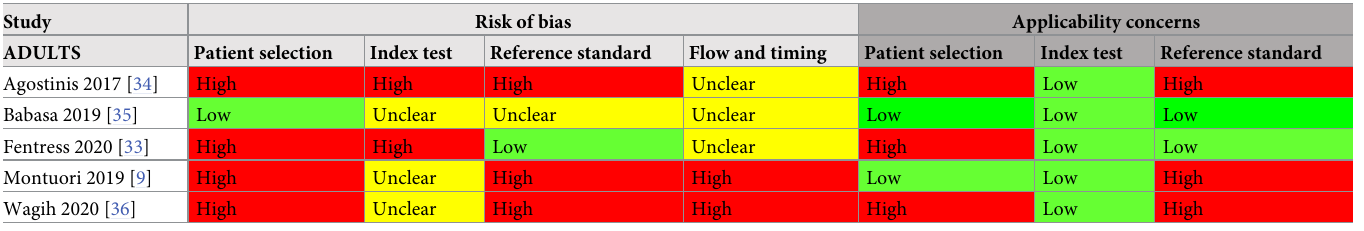
Table 3. QUADAS-2 assessments for studies in